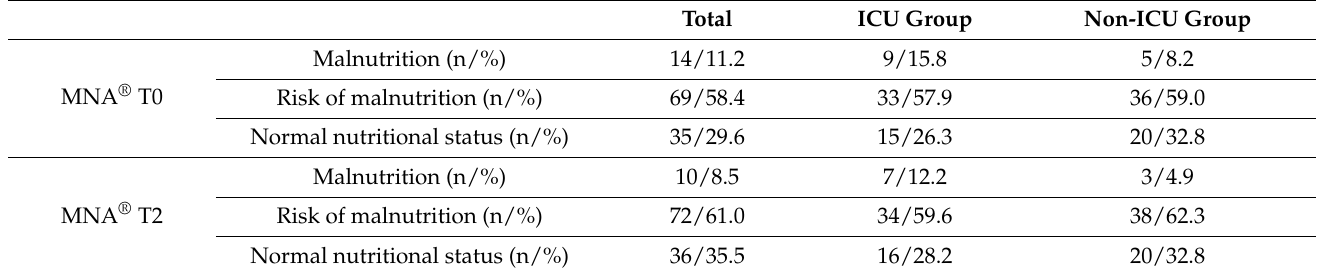
Table 6. Characterization of subjects and respective results from Mini Nutritional